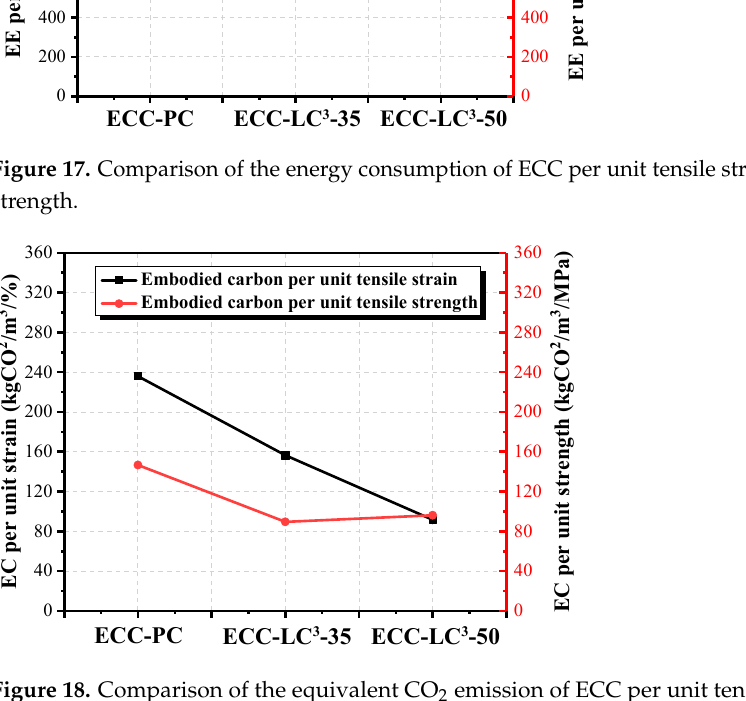
Figure 18. Comparison of the equivalent CO 2 emission of ECC per unit tensile strain and per unit tensile strength.